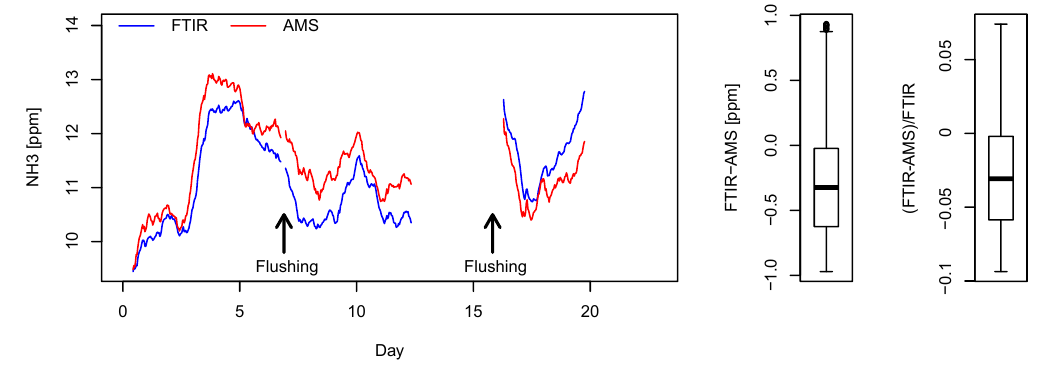
Figure 7. Twenty four-hour rolling average NH 3 concentration measured by AMS and FTIR in the field test. Missing measurements were removed, and the remaining data were presented as continuous time